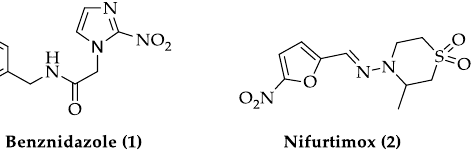
Figure 1. Currently available drugs in clinical use for American trypanosomiasis management.